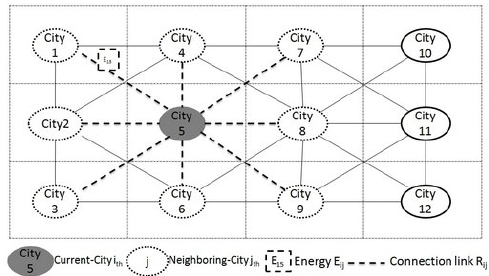
Figure 8: Environment modeling of the